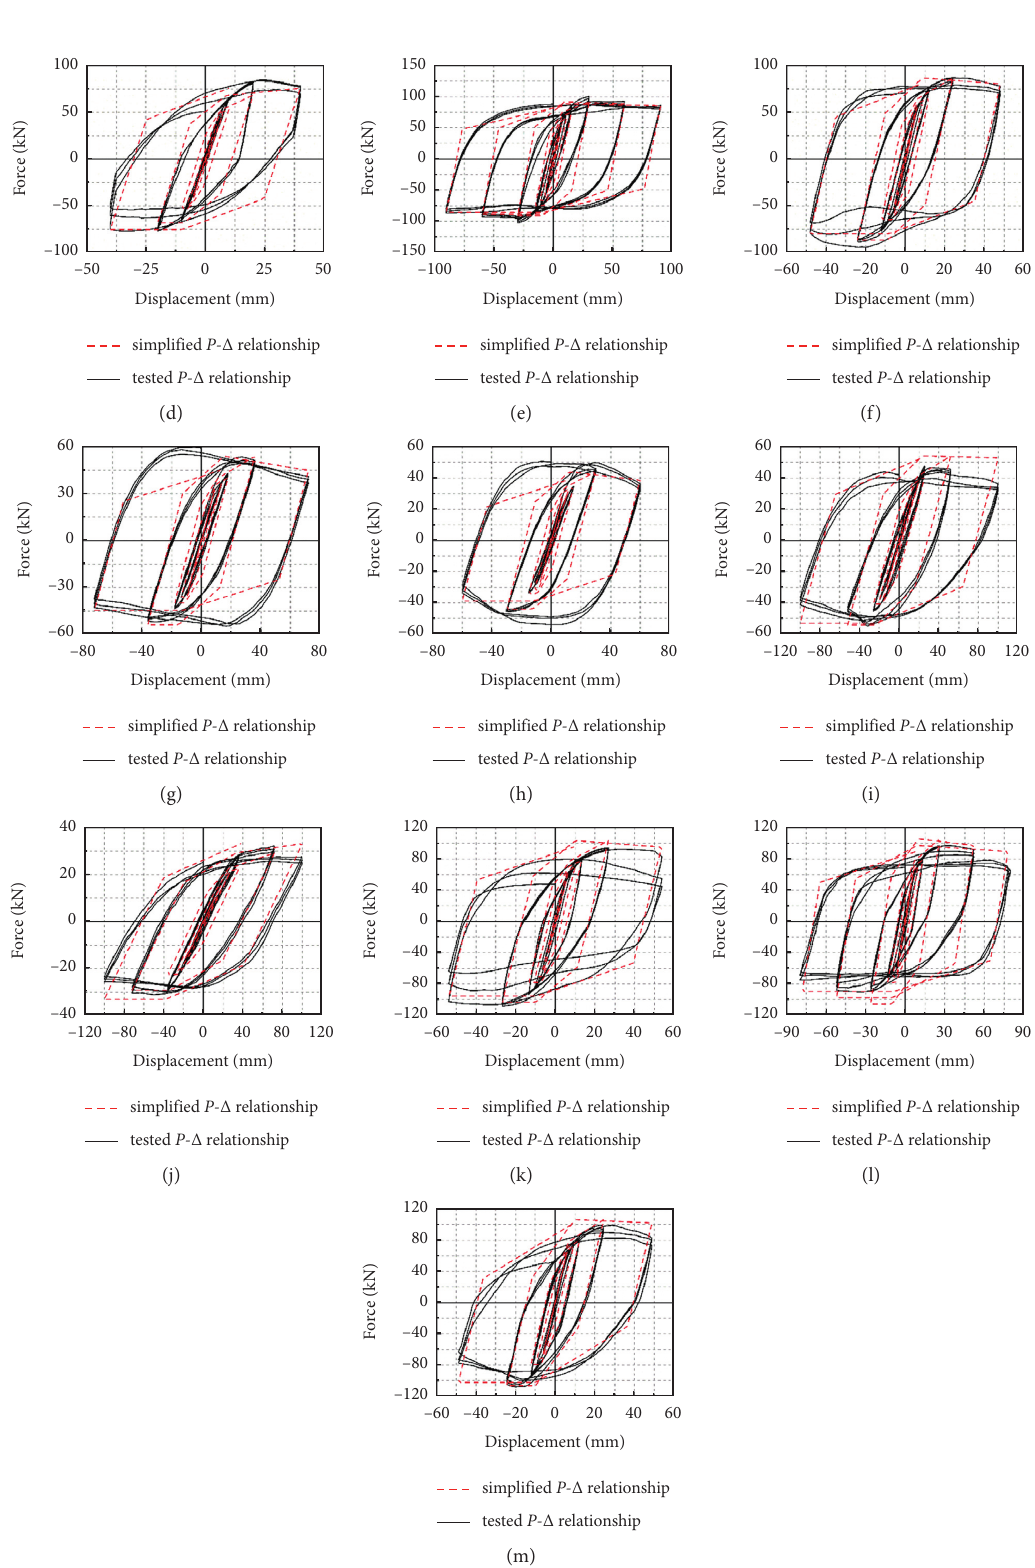
Figure 14: Comparison of simplified P - Δ relationship with tested P - Δ relationship. (a) E1.0-c45-0.2. (b) E1.3-c45-0.2. (c) E1.8-c45-0.2. (d) E2.3-c45-0.2. (e) E1.8-c45-0.1. (f) E1.8-c45-0.3. (g) E1.8-c45-0.2b. (h) E1.8-c45-0.3b. (i) E1.8-c45-0.2m. (j) E1.8-c45-0.2l. (k) E1.8-c60-0.2. (l) E1.8-c75-0.2. (m)